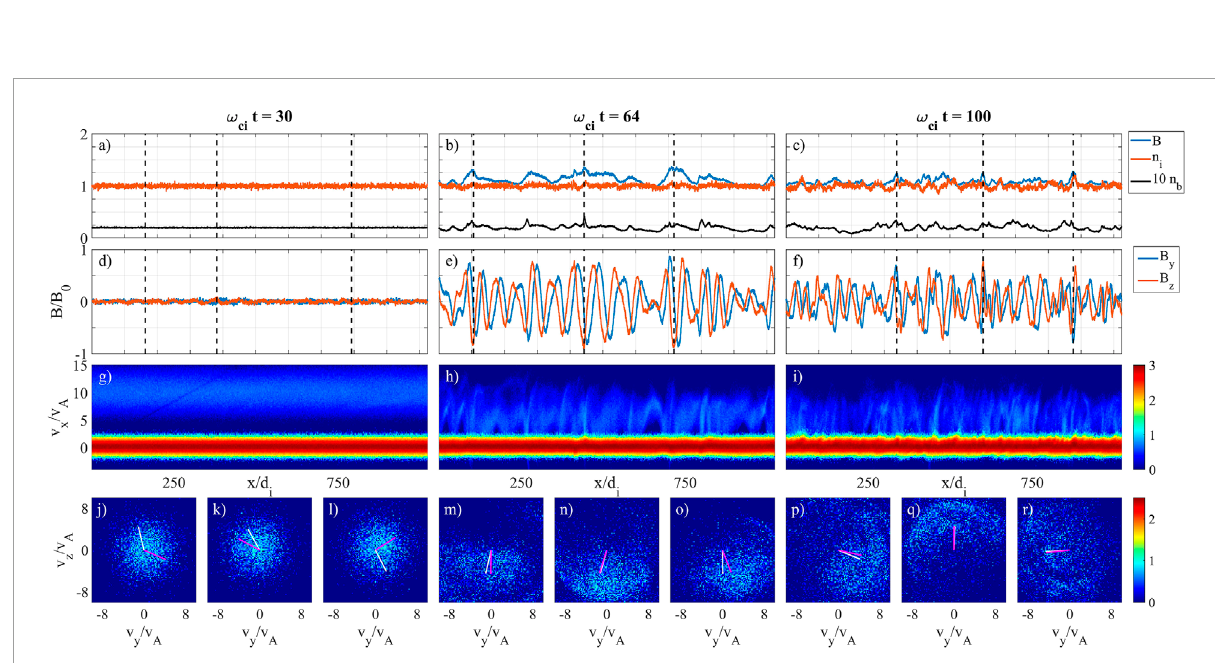
FIGURE 3 Similar plots as in Figure 2 , but with warm background ( v thi = √ 2 T i / m i = v A or β i = 1) and beam ( v thb = 3 v A ) ion populations. Again, the left panels are at early time t ω ci = 30, middle panels are at t ω ci = 64, and right panels are at t ω ci = 100. (A–C) Background (red) and beam (black) ion density profiles and magnetic field strength (blue). (D–F) Wave magnetic field components B y and B z . (G–I) Parallel x − v x phase space distribution of the ions, showing the dense background at v x ∼ 0 and the beam with an Alfven Mach number of M A = 10. (J–R) Beam ion distributions in the perpendicular v y − v z plane at the points marked by the vertical dashed lines in (A–C) . The white lines show the direction of the perpendicular wave magnetic fields B y and B z , and the magenta lines show the direction of the bulk beam perpendicular